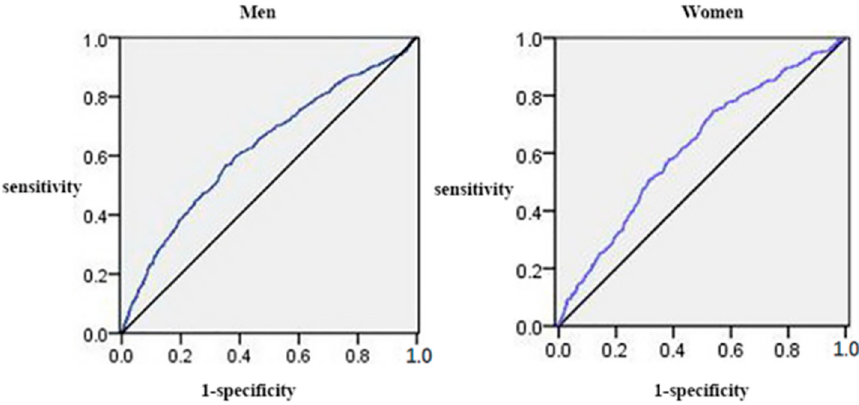
Figure 3. The discriminatory power of SUA in the prediction of elevated ALT. Area under the receiver operating characteristic curve of SUA was used to identify subjects with elevated ALT according to sex.